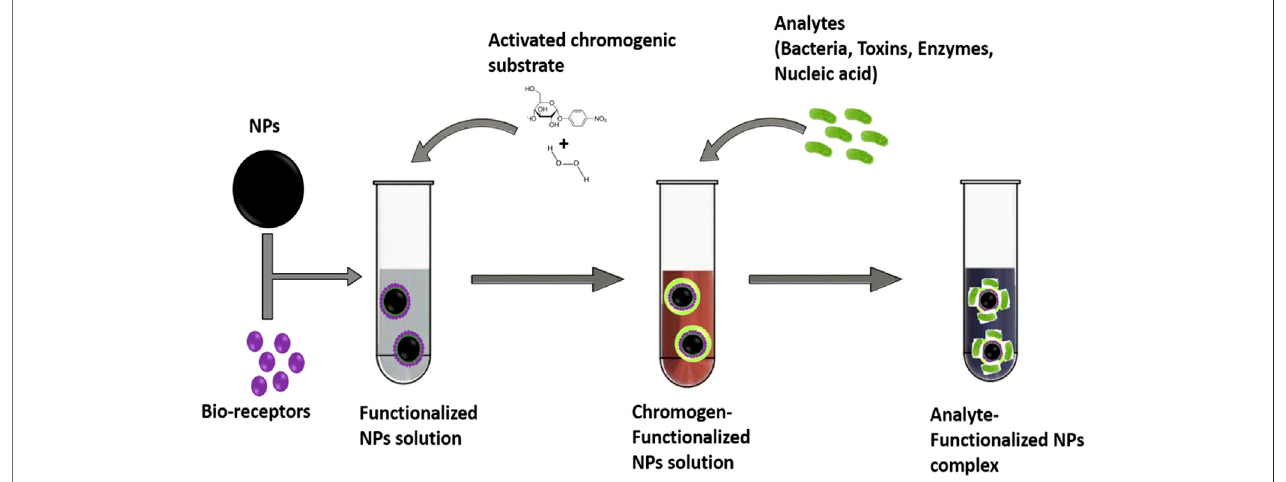
FIGURE 2 | Descriptive image on the colorimetric detection of analytes using bio-receptors/chromogens – functionalized nanoparticles